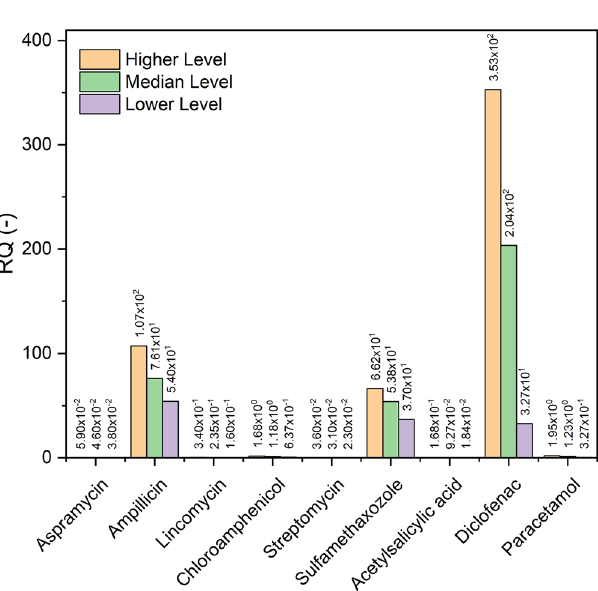
Figure 7. Risk quotients (RQs) of PhACs in STP